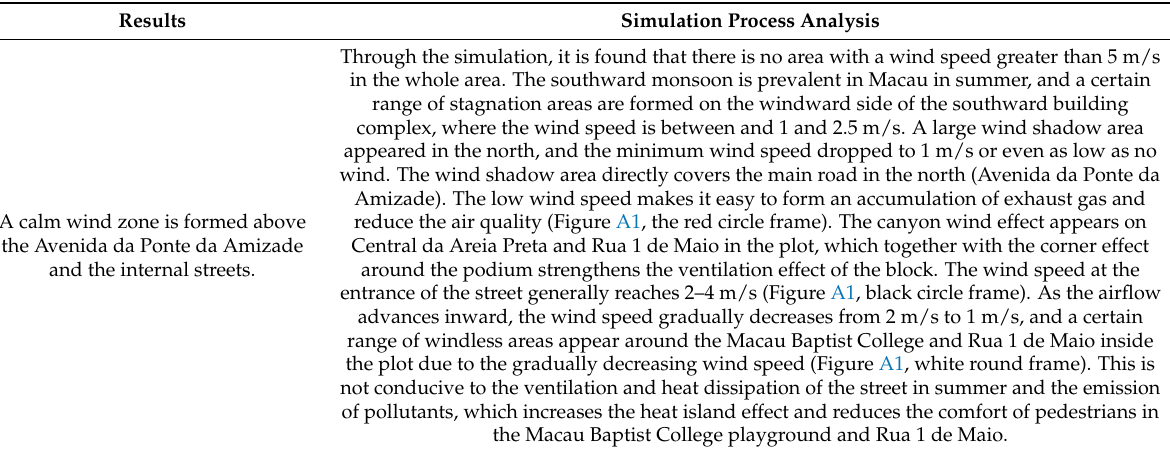
Table A2. Wind Environment Simulation at Two Altitudes: Pedestrian Height and Standard